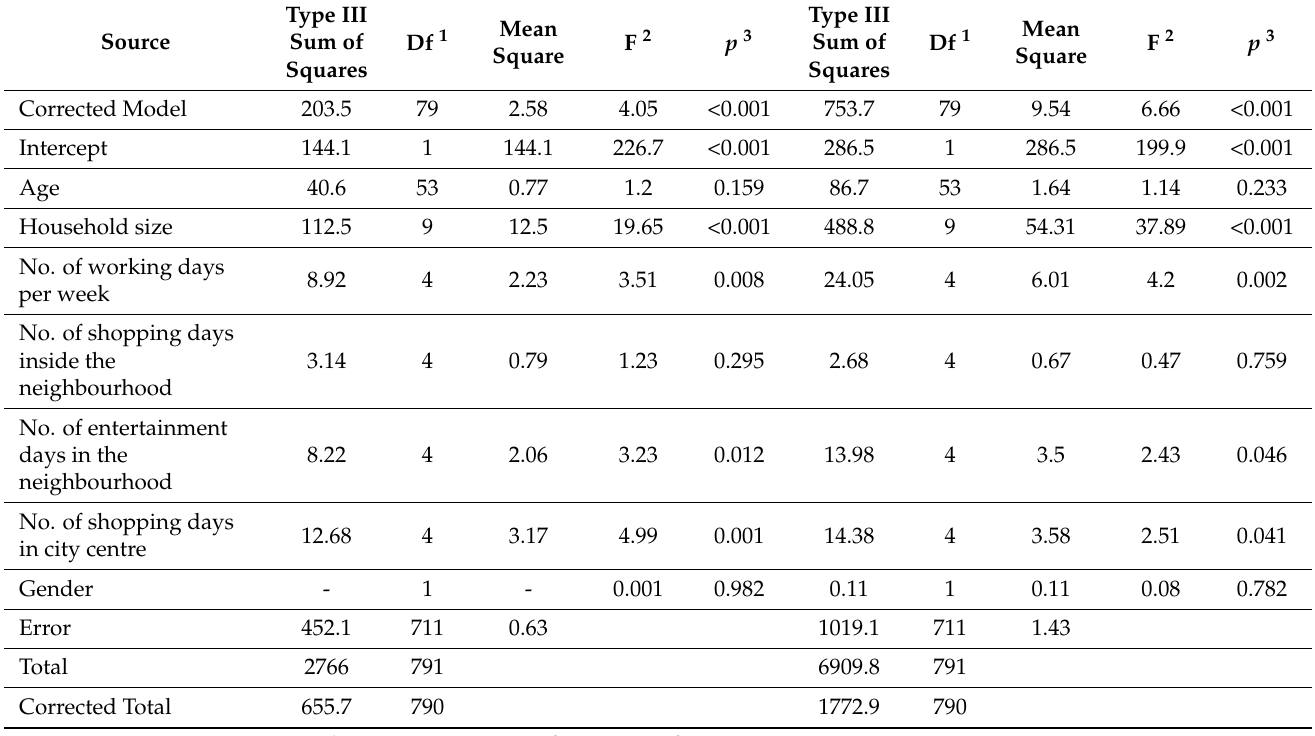
Table 3. Tests of between-subjects for OLS (R 2 = 0.31) and WLS (R 2 = 0.425) models of car ownership in Kerman (N = 791).